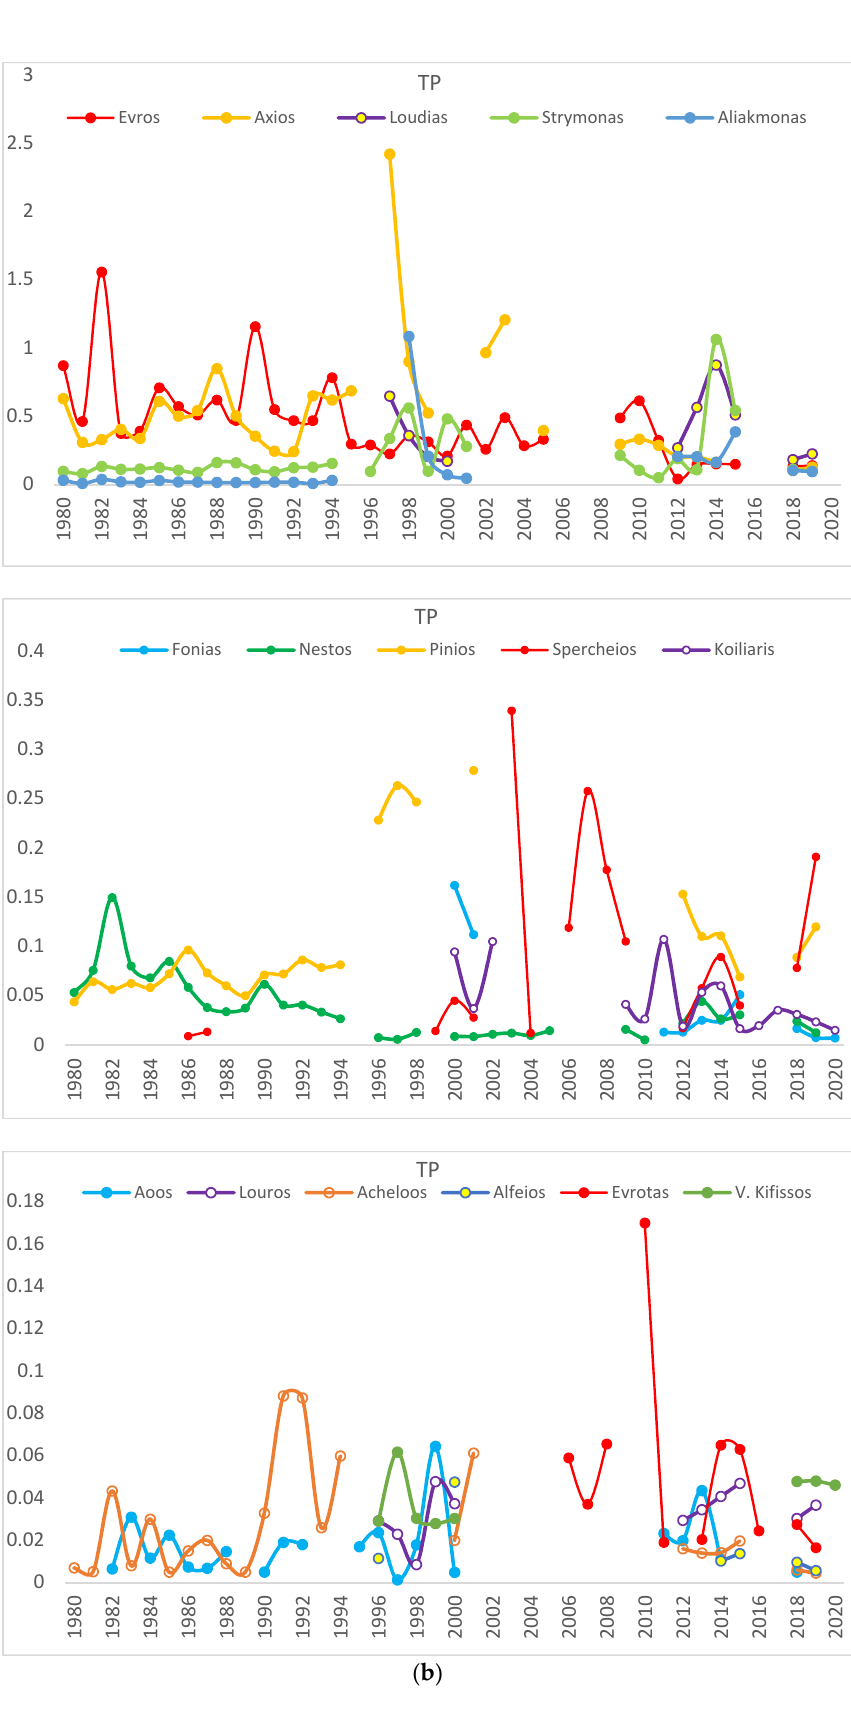
Figure 2. 40-year nitrate (N-NO 3 ) ( a ) and TP ( b ) variation in the examined Greek rivers (in mg/L).